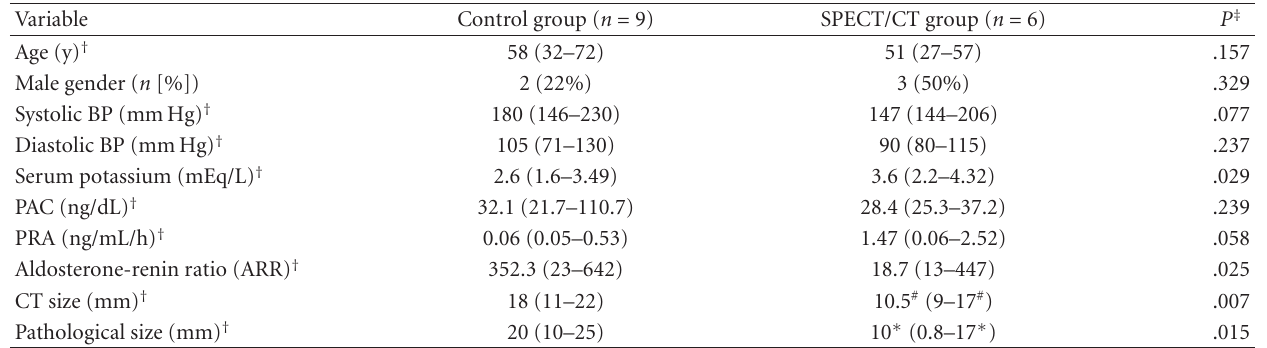
Table 3: Comparison of variables between the control and SPECT/CT